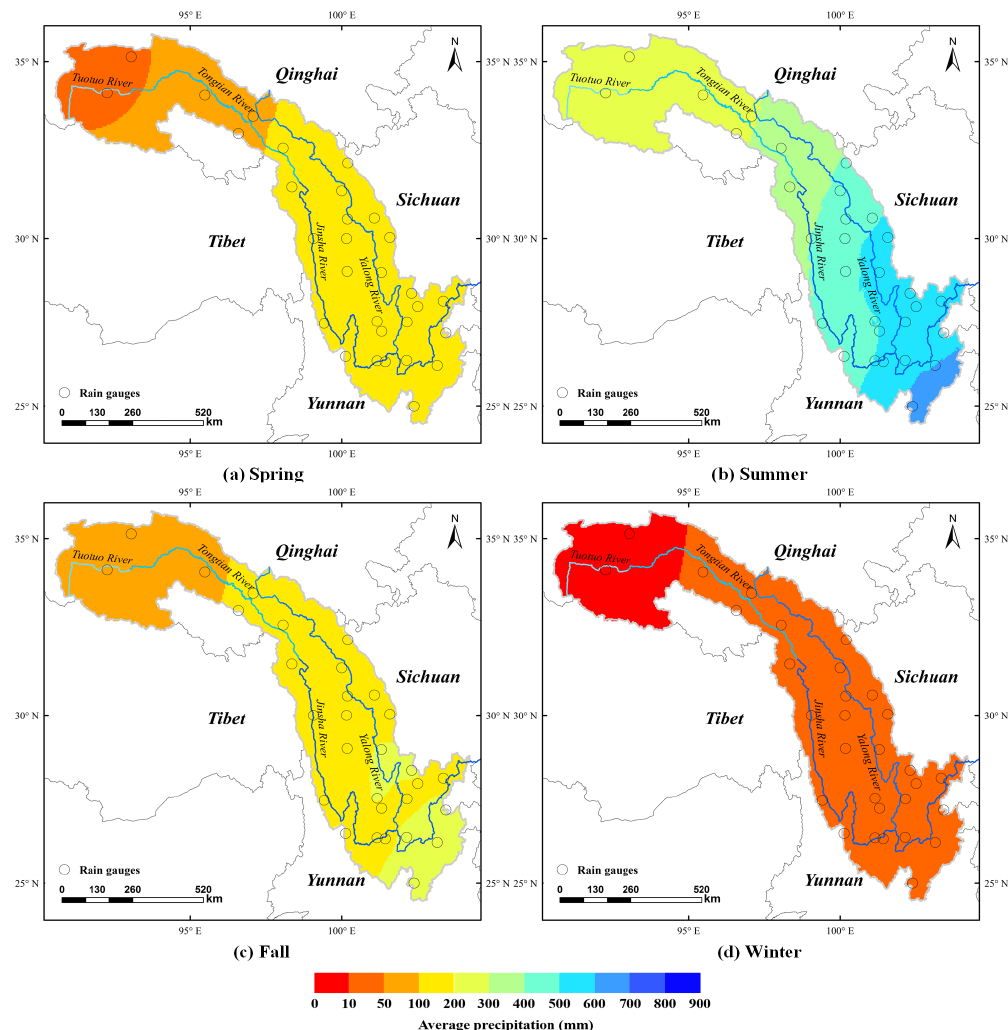
Figure 2. The multi-annual (1990–2014) average seasonal precipitation over the Jinsha River basin interpolated from 30 rain gauges down- loaded from the China Meteorological Administration